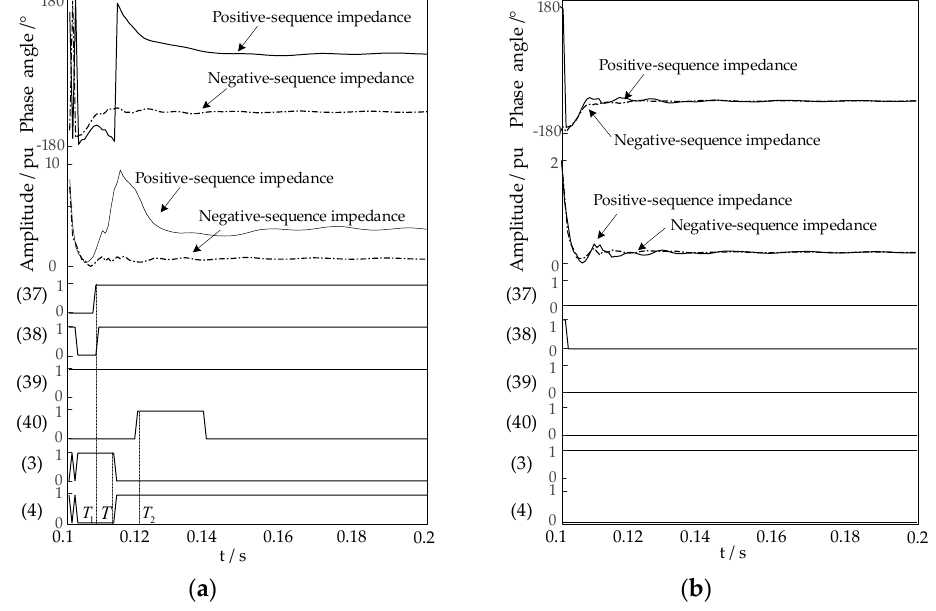
Figure 19. Performances of the mitigation countermeasure in Case 4 ( a ) busbar n ; and ( b ) busbar m .